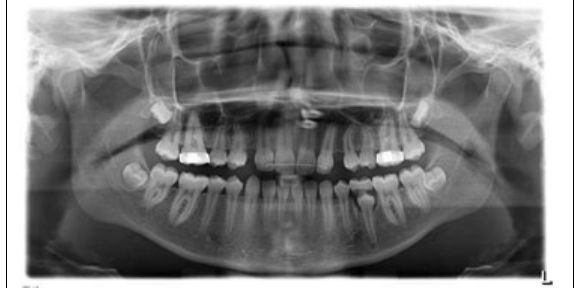
Figure 5. Pretreatment panoramic radiograph.